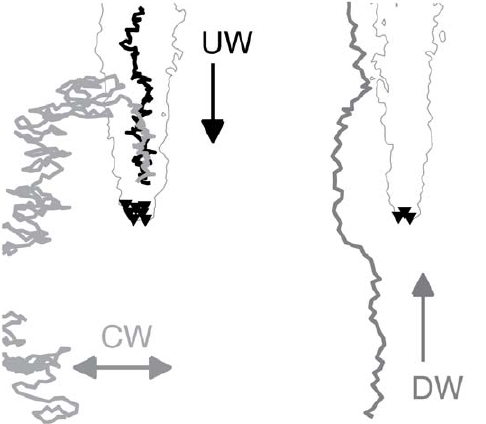
Figure 2. Examples of mosquito trajectories. Example mosquito trajectories for upwind (UW), downwind (DW), and crosswind (CW) plume-finding behaviors. The stationary hosts are distributed into two groups and the contour of the odor plume marks a snapshot of the CO 2 sensing threshold of the mosquito. The UW and CW mosquitoes successfully locate a host; the DW mosquito is unsuccessful. The CW mosquito leaves and re-enters the domain.